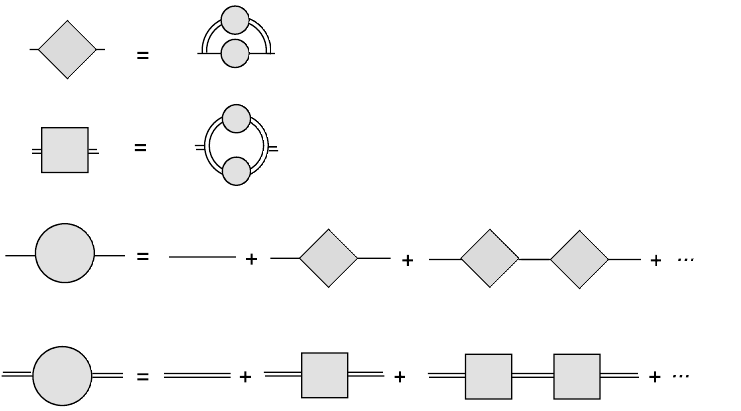
Figure 7 . Diagrammatic presentation of the Schwinger-Dyson equations. The diamonds represent the self-energy of the a or (cid:12) a (cid:12)elds. The squares represent the self-energy of the (cid:31) ab or (cid:25) ab (cid:12)elds. The propagators with circular blobs are exact and are computed as shown in the bottom two